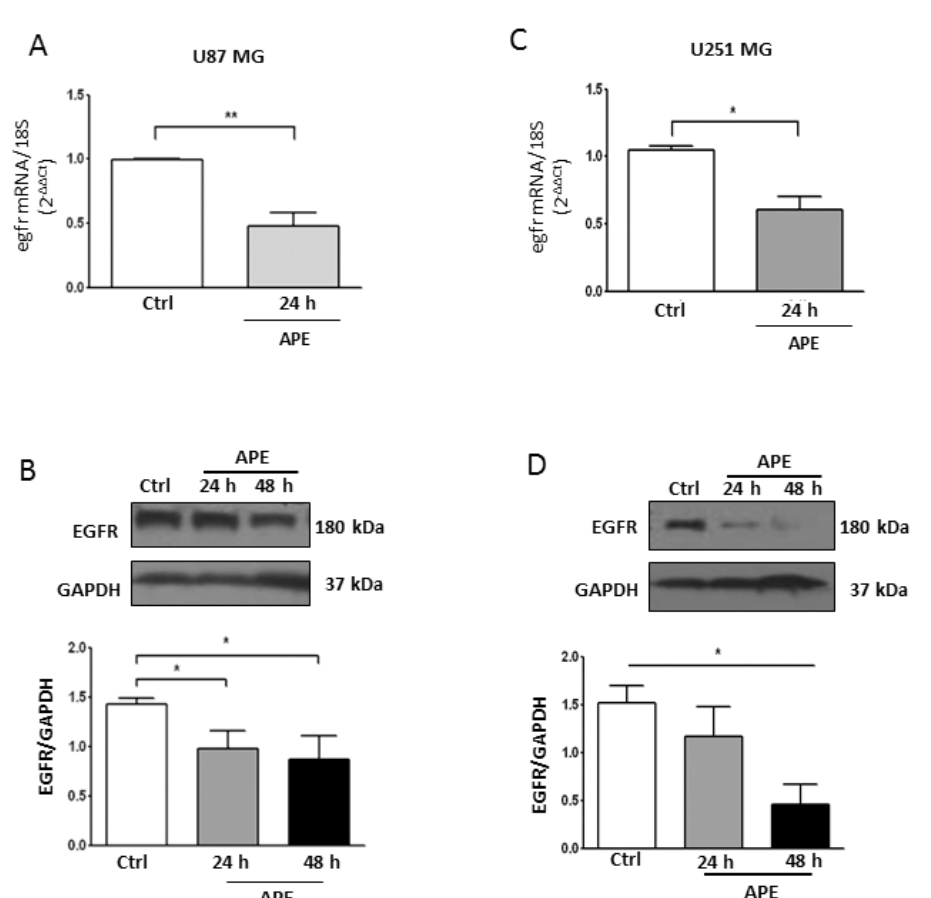
Figure 6. EGFR Expression in GBM cell lines. Real time RT-PCR and Western blot analysis ( A , B , respectively) of EGFR in U87MG. Parallel analyses were performed in U251MG cells ( C , D , respectively). Both lines were untreated or treated with 100 µ M APE for 24 and 48 h. Representative blots are shown from three independent experiments. GAPDH was used as the internal reference protein. (* p < 0.05; ** p < 0.01; t -test and one-way ANOVA